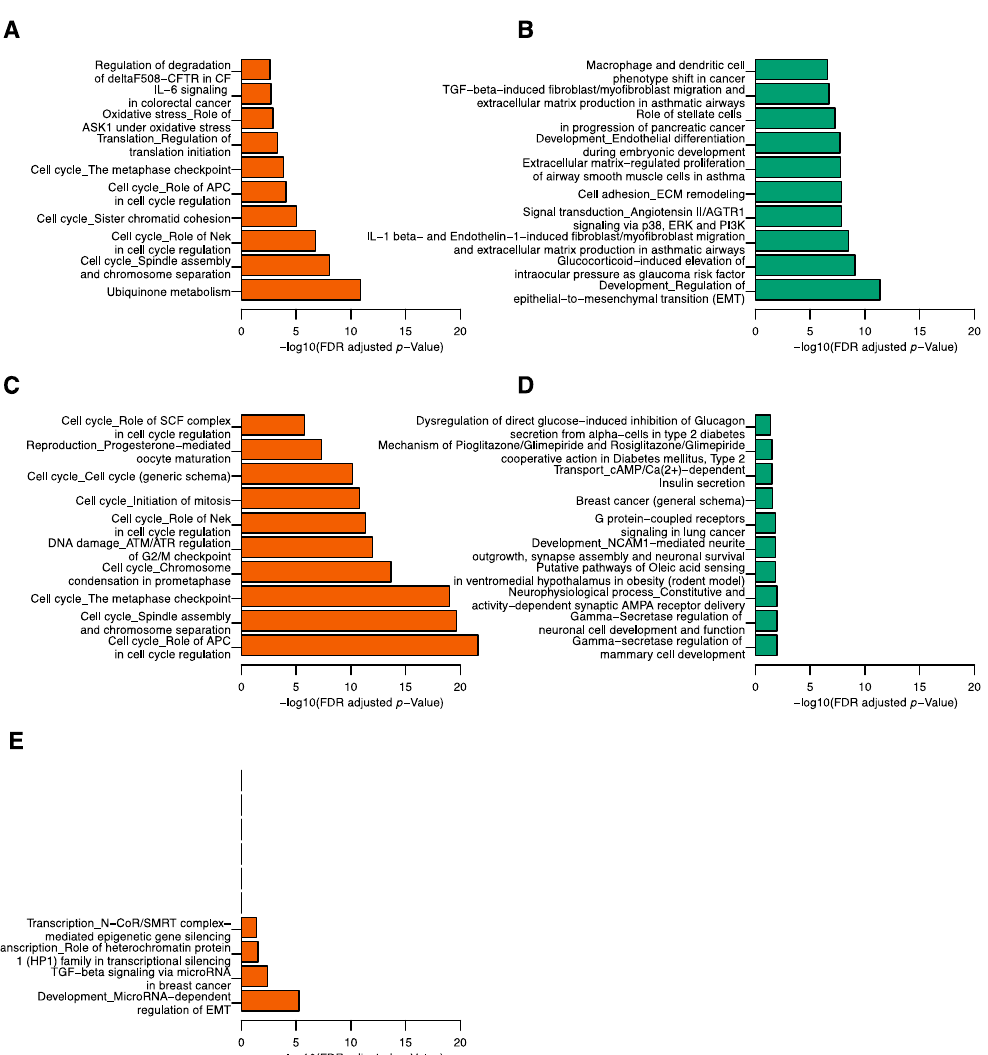
Figure 2. Top gene pathways associated with tRFs. Top 10 pathways from the positively ( A ) and negatively ( B ) correlated genes of tRFdb-5024a, positively ( C ) and negatively ( D ) correlated genes of ts-34, and positively correlated genes of ts-58 ( E ).